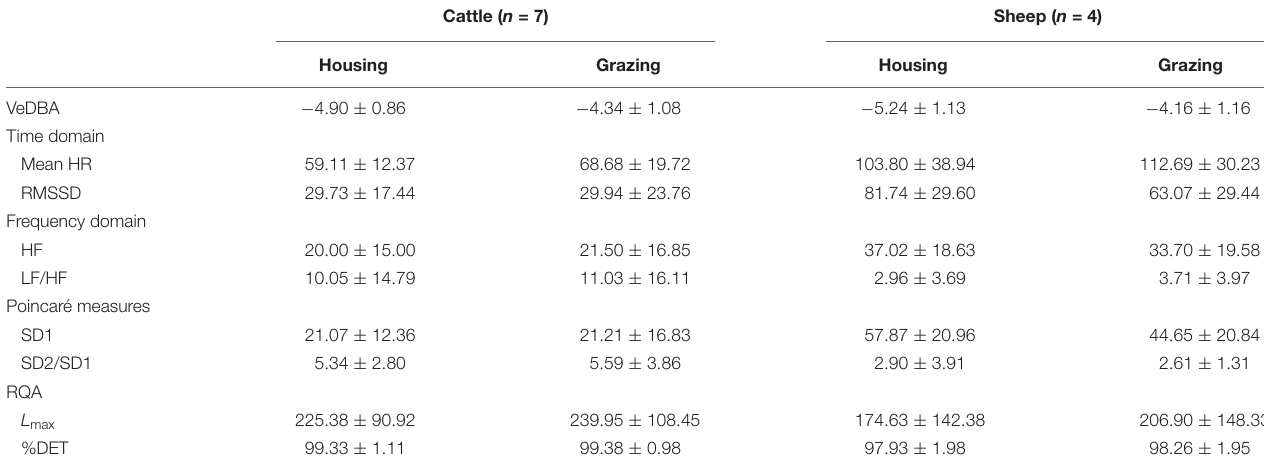
TABLE 2 | Mean and standard deviations of VeDBA, mean HR, and HRV parameters in animals under the two management systems. Cattle ( n = 7) Sheep ( n = 4) Housing Grazing Housing